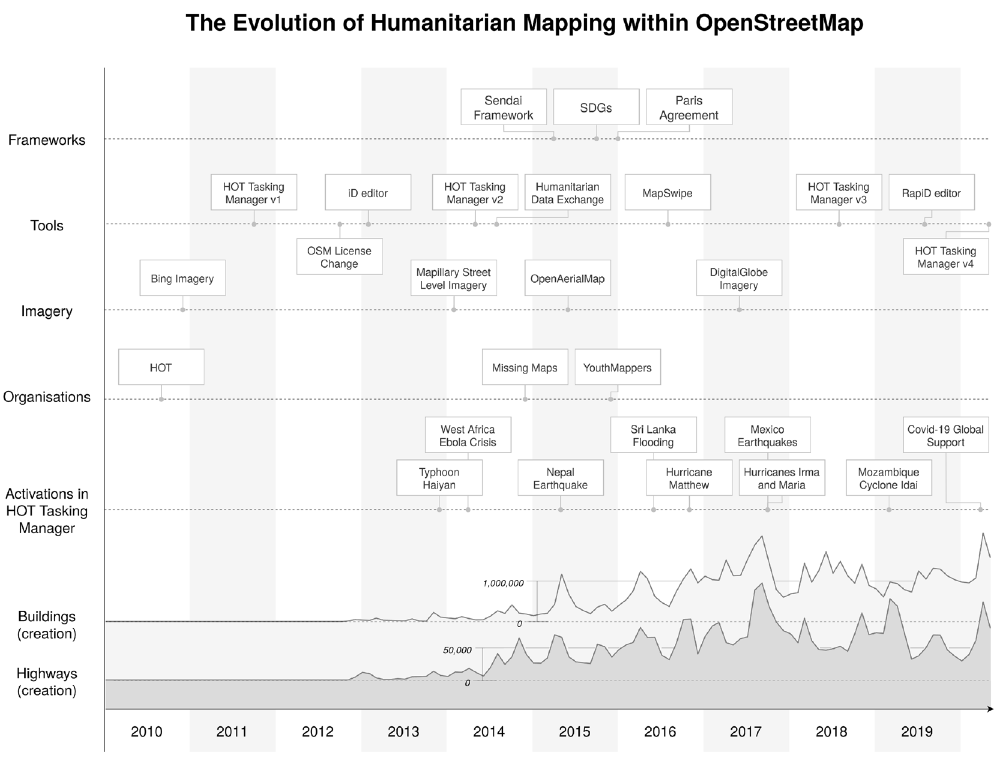
Figure 1. Sketch of the evolution of humanitarian mapping in OSM in regard to major disaster activations, the socio-technical development of the community and global political frameworks. The plots at the bottom show the number of buildings and highways added to OSM. Created using drawio 13.11.0 (https ://githu b.com/jgrap h/ drawi